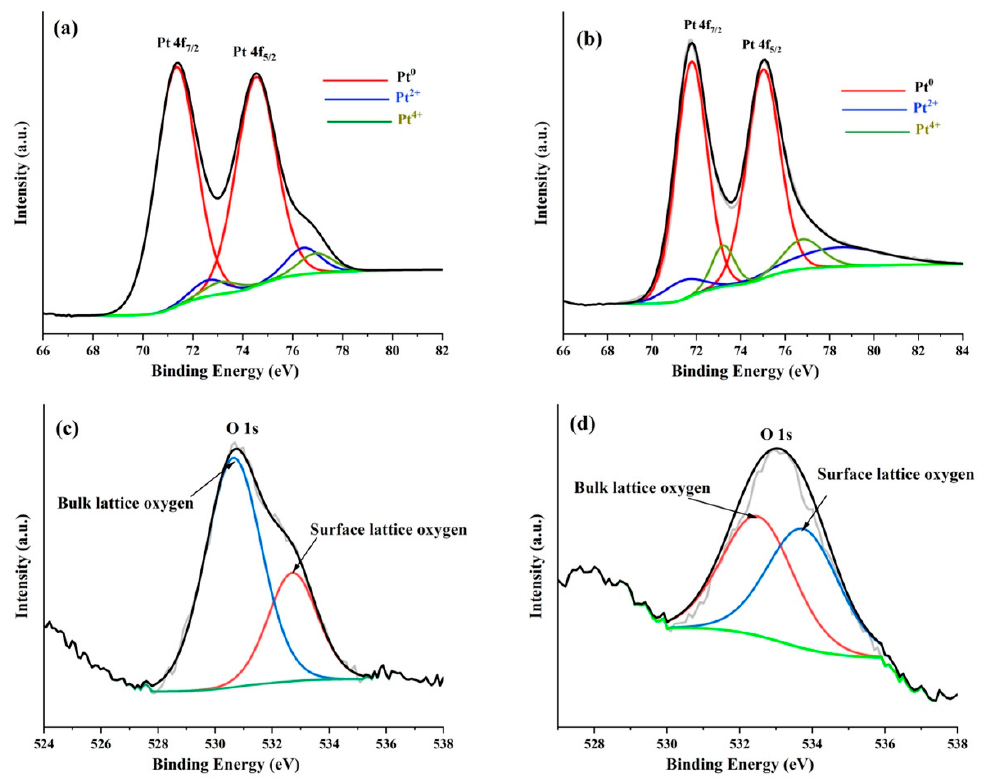
Figure 7. High-resolution XPS spectra of Pt 4f core level and O 1s core level. ( a , c ) Pt/Ti mesh. ( b , d ) Pt/TiO 2 /Ti mesh.